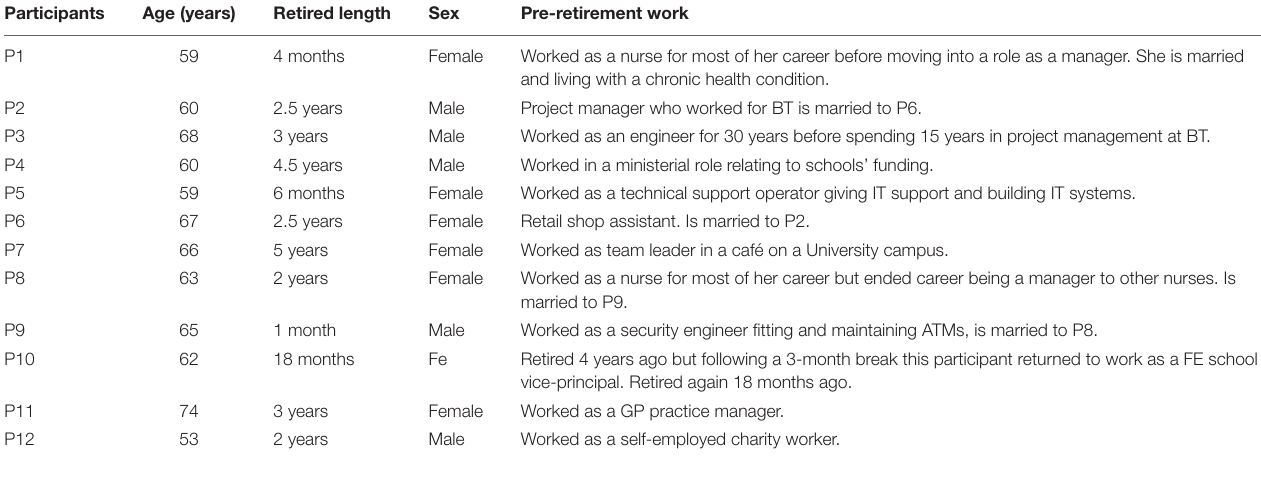
TABLE 1 | A descriptive overview of